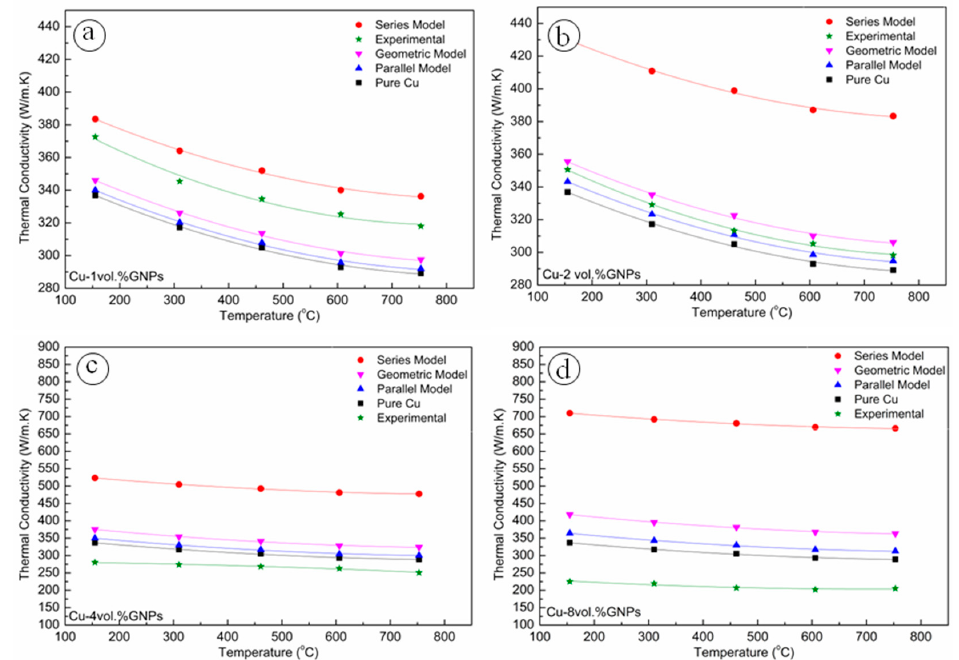
Figure 14. Comparison of experimental thermal conductivities of ( a ) Cu-1 vol % GNPs, ( b ) Cu-2 vol % GNPs, ( c ) Cu-4 vol % GNPs, ( d ) Cu-8 vol % GNPs, to the prediction by different models [142], Reproduced from [142], with permission from Springer Nature, 2018.